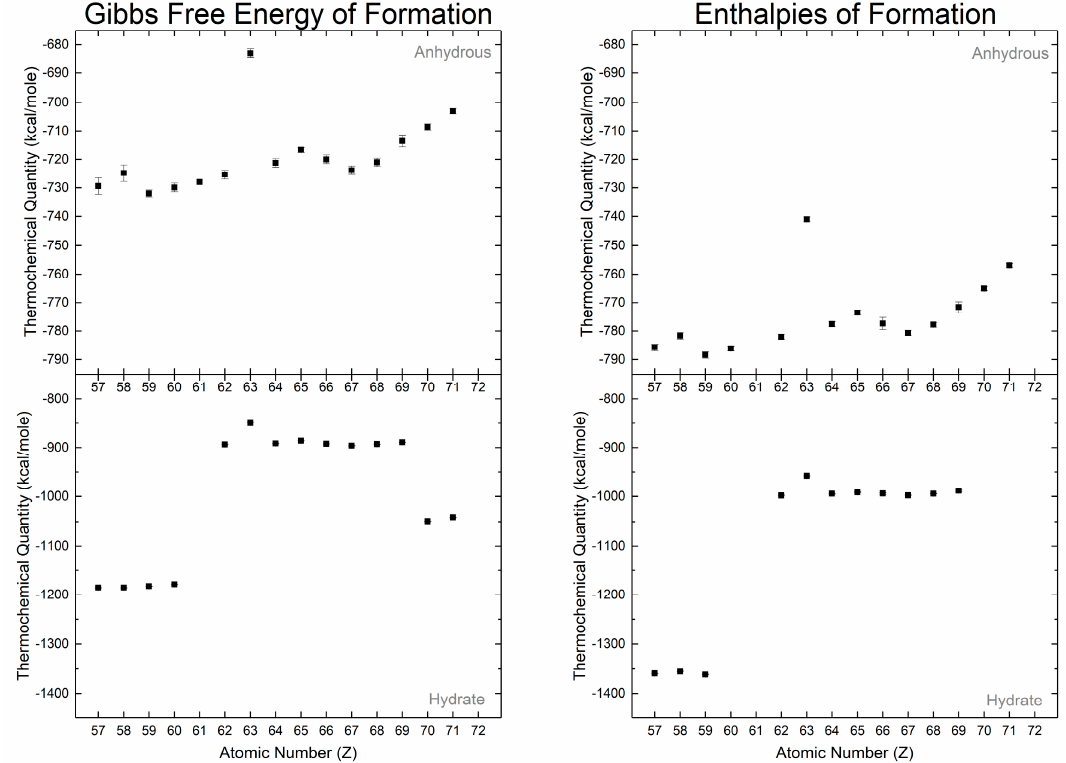
Figure 7. Gibbs free energies of formations and enthalpies of formation from Karapet'yants [129], [132]. Hydration of the rare earth carbonates masks decreasing thermochemical values with respect to atomic number as observed in the anhydrous phases.